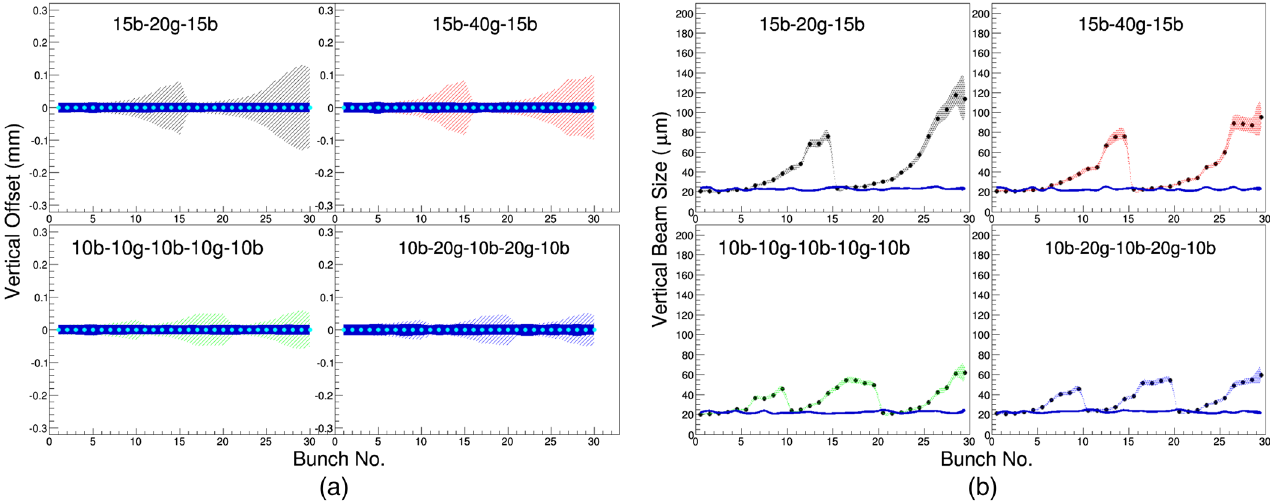
FIG. 11. Vertical bunch (a) motion and (b) size as a function of bunch number for different bunch patterns (lightly shaded ¼ RMS amplitude with vertical feedback off, filled ¼ feedback on, dots ¼ mean value). In the notation used in the legends, “ b ” refers to a bunch, and “ g ” refers to a